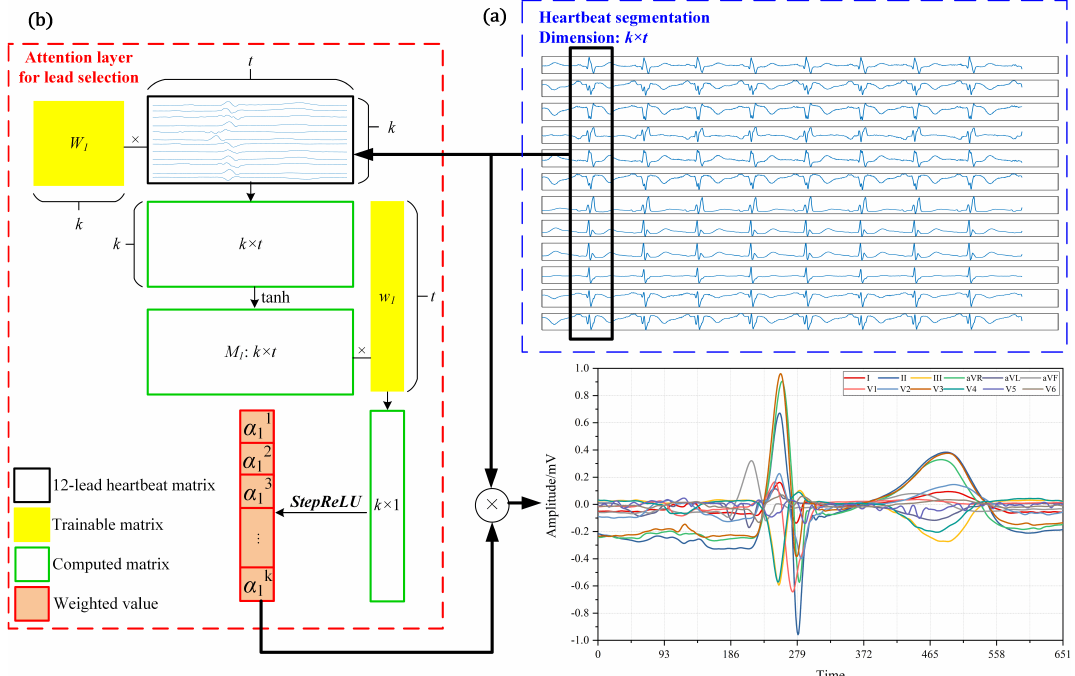
Figure 2. Schematic diagram of multi-lead attention (MLA) mechanism: ( a ) heartbeat segmentation; and ( b ) MLA mechanism outputs the weighted heartbeat